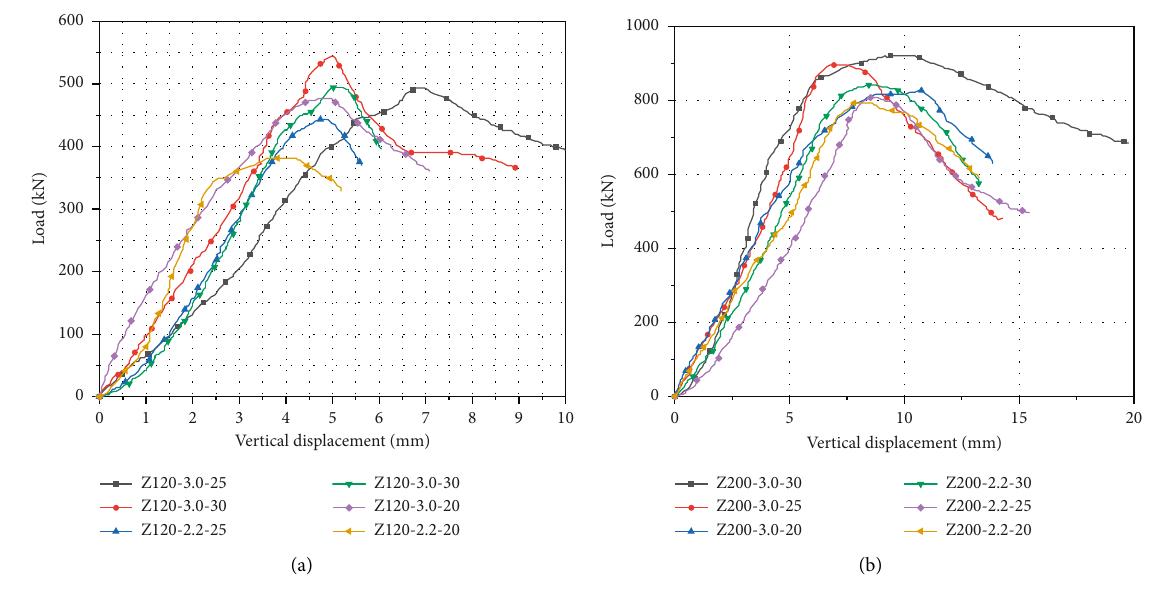
Figure 10: Load-displacement curves. (a) Z120 series. (b) Z200